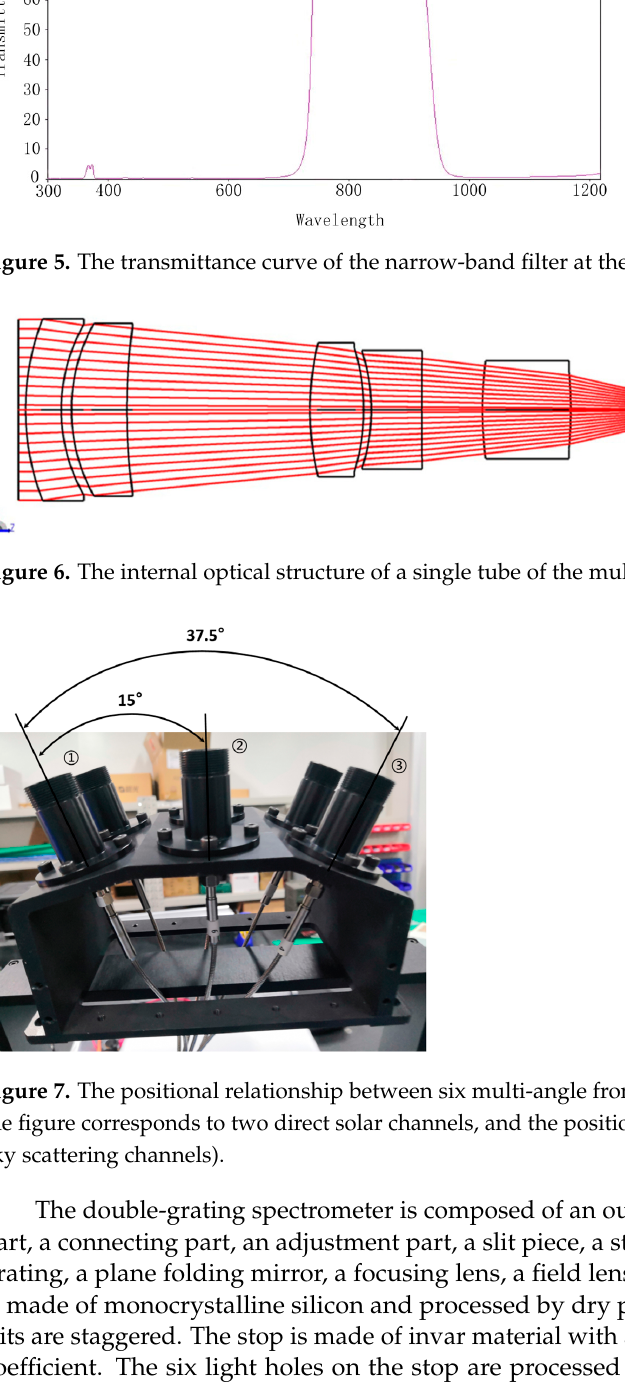
Remote Sens. 2022 , 14 , x FOR PEER REVIEW 8 of 36 Figure 4. The components of DGSS: ( a ) Schematic diagram; ( b ) Physical diagram. The multi ‐ angle front telescope system consists of six telescopes. A narrow ‐ band filter is installed at the front end of the telescope to suppress out ‐ of ‐ band radiation. Its transmittance curve is shown in Figure 5. The telescope has a focal length of 22.92 mm, a field of view of 1.5°, and an F ‐ number of 2.27. The optical structure of the telescope sys ‐